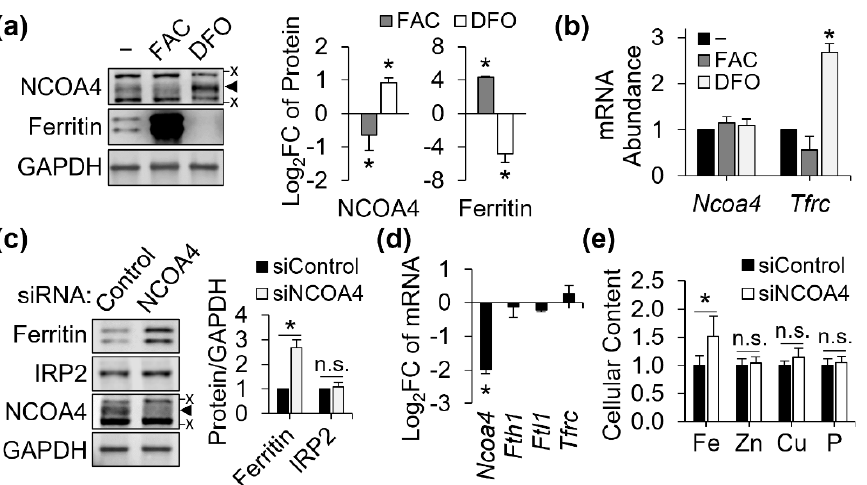
Figure 1. NCOA4 responds to cellular iron status and controls cellular ferritin and iron levels in J774 macrophages. J774 macrophages were treated with ferric ammonium citrate (FAC; 100 μg/mL) and deferoxamine (DFO; 100 μM) for 18 h to produce cellular iron overload and deficiency, respectively. Iron adequate cells (−) were without any iron treatments. For NCOA4 knockdown, cells were transfected with siRNA and cultured for 24 h. ( a ) NCOA4 protein abundance and its inverse relationship to cellular iron and ferritin levels ( n = 3 independent experiments). ( b ) Responses of Ncoa4 and Tfrc mRNA to iron treatments, normalized to Tbp ( n = 3 independent experiments). ( c ) Effects of NCOA4 RNAi on ferritin and IRP2 protein abundance. Protein quantitation is normalized to GAPDH ( n = 4 independent experiments). ( d ) Responses of iron homeostasis genes to Ncoa4 silencing at the transcript level efficiency, normalized to Tbp ( n = 4 independent experiments). ( e ) Cellular mineral contents normalized to cell counts ( n = 5 biological replicates). All data presented as mean ± SD. *, p <